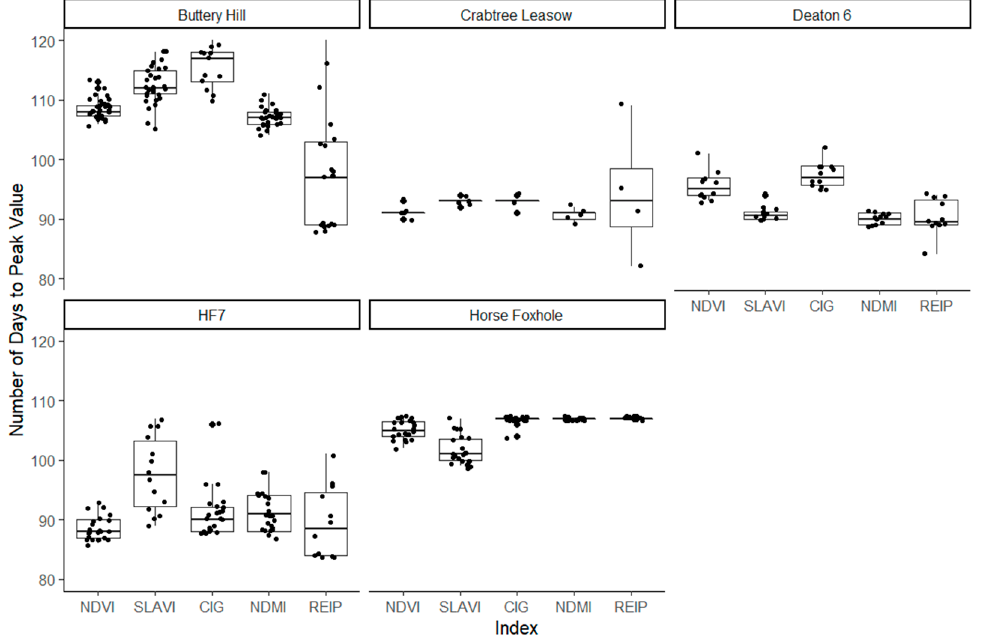
Figure 4. Illustration of the spread of the observed number of days between planting day and the peak value of Normalized Difference Vegetation Index, Specific Leaf Area Vegetation Index, Normalized Difference Moisture Index, and the Red Edge Inflection Point.